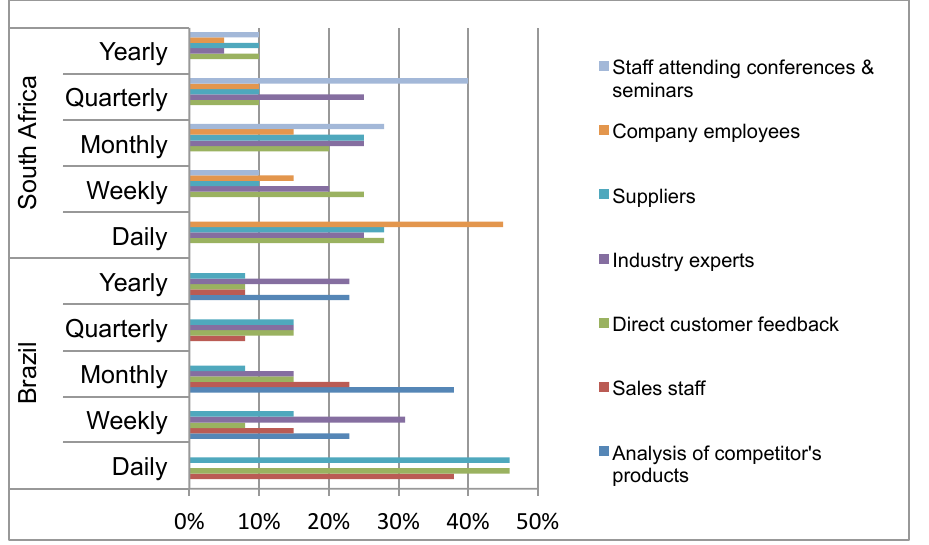
Figure 3: Use of primary sources